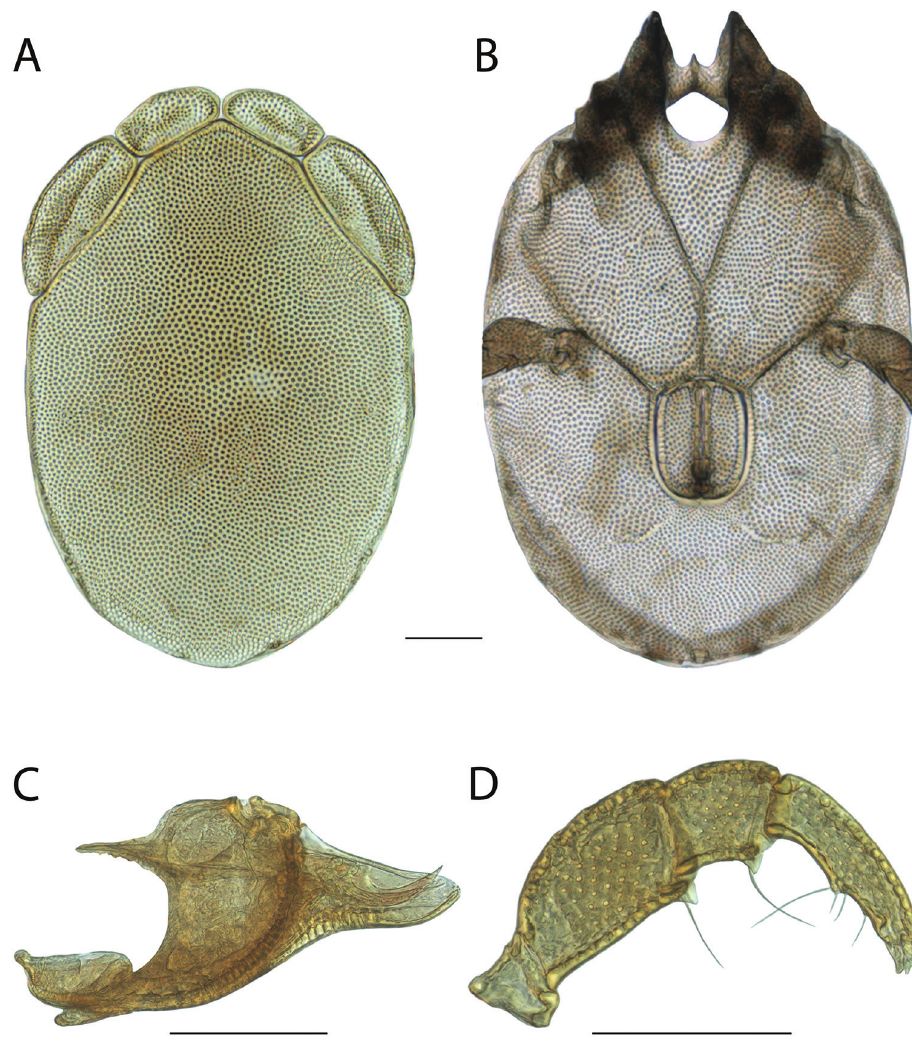
Figure 131. Torrenticola leviathan sp. n. male (teneral): A dorsal plates B venter (legs removed) C sub- capitulum D pedipalp (setae not accurately depicted). Scale = 100